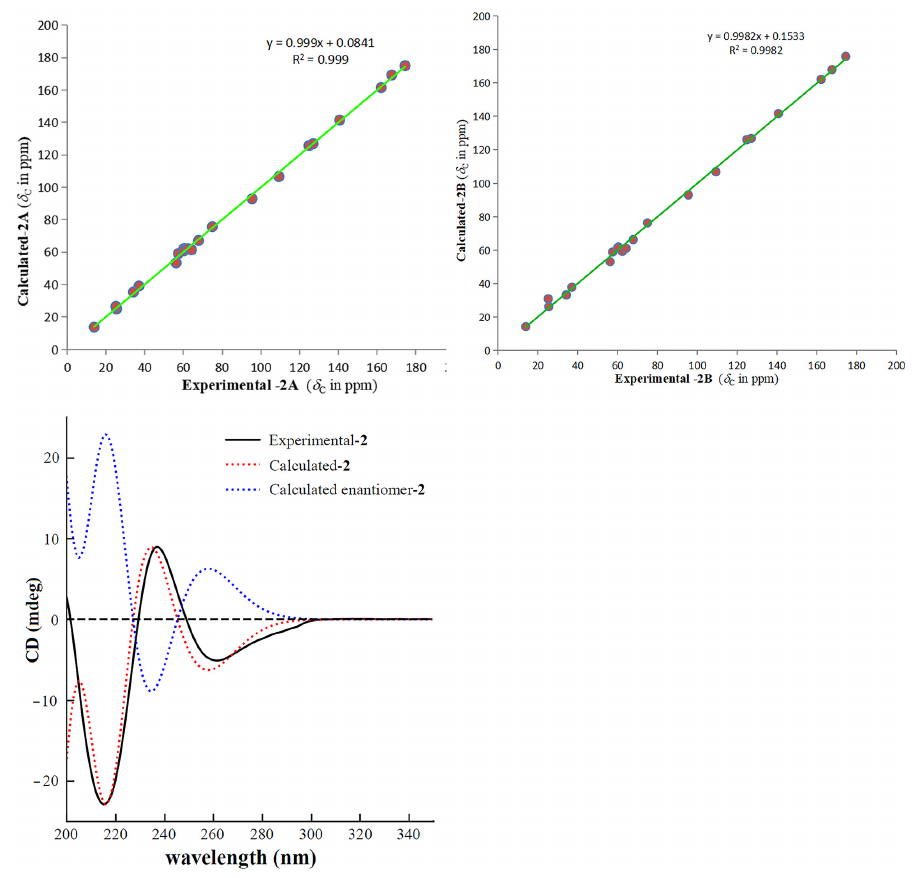
Figure 6. Regression analysis of the NMR calculations of the two possible configurations ( 2A and 2B ) and ECD calculation curves of 2 .